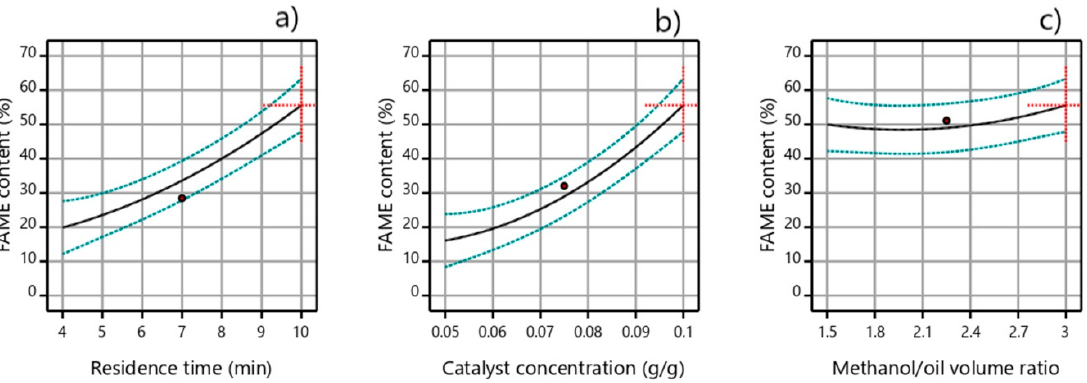
Figure 9. Perturbation plots of FAME content versus ( a ) residence time, ( b ) catalyst concentration, and ( c ) methanol/oil volume ratio (60 °C, catalyst concentration of 0.1 g g -1 , residence time of 10 min, and methanol/oil volume ratio of 3:1).